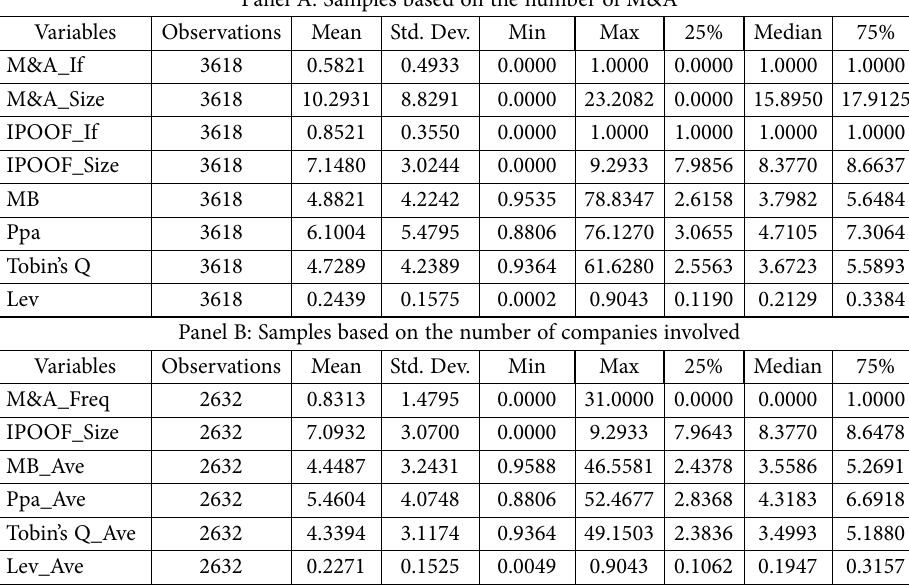
Table 9. Descriptive statistics Panel A: Samples based on the number of